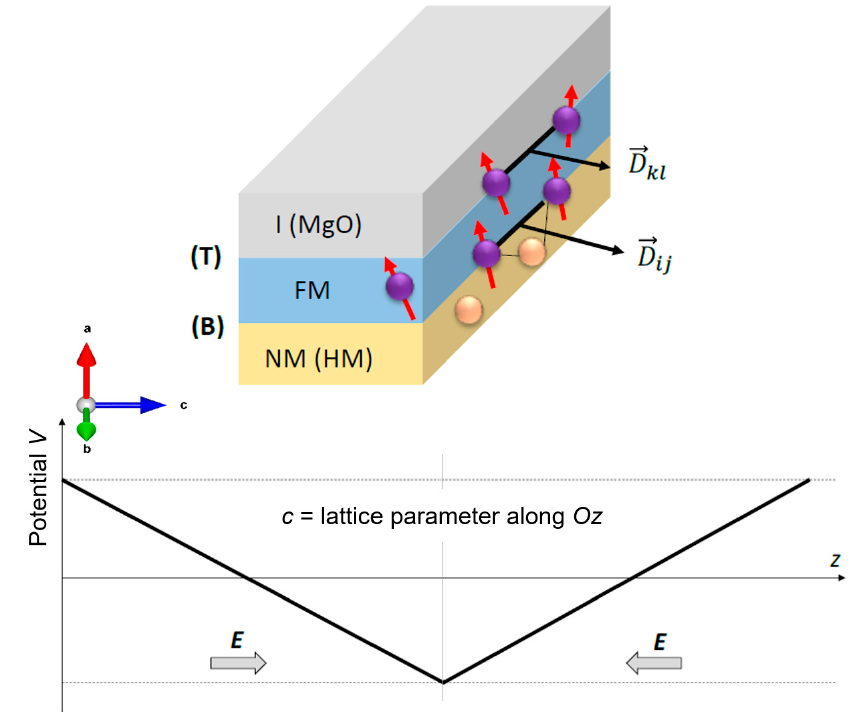
Figure 3. Top: Multilayer stack in which the PMA and DMA result from additive effects of the top and bottom interfaces. Bottom: zig-zag potential model used for simulating the effect of an electric field on the electronic structure of a multilayer stack (adapted from [27]).